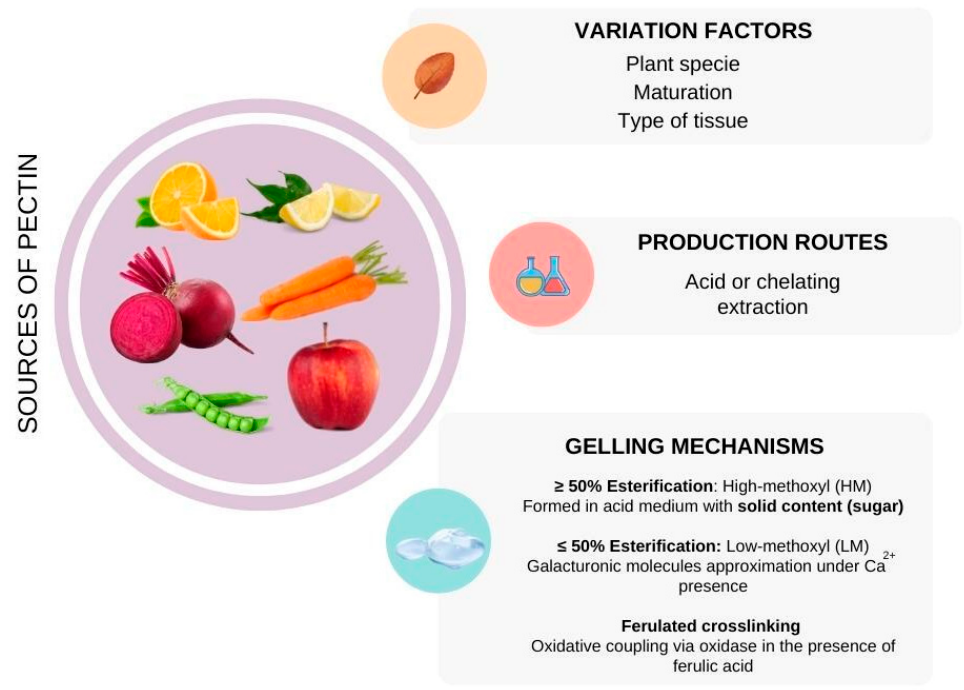
Figure 10. Pectin: sources, extraction method, and gelling